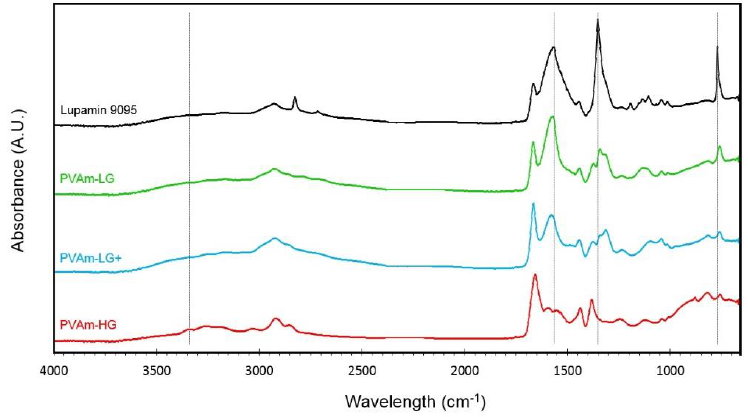
Figure 5. FTIR-ATR spectra of commercial Lupamin 9095 and purified PVAm with different degree of purification.